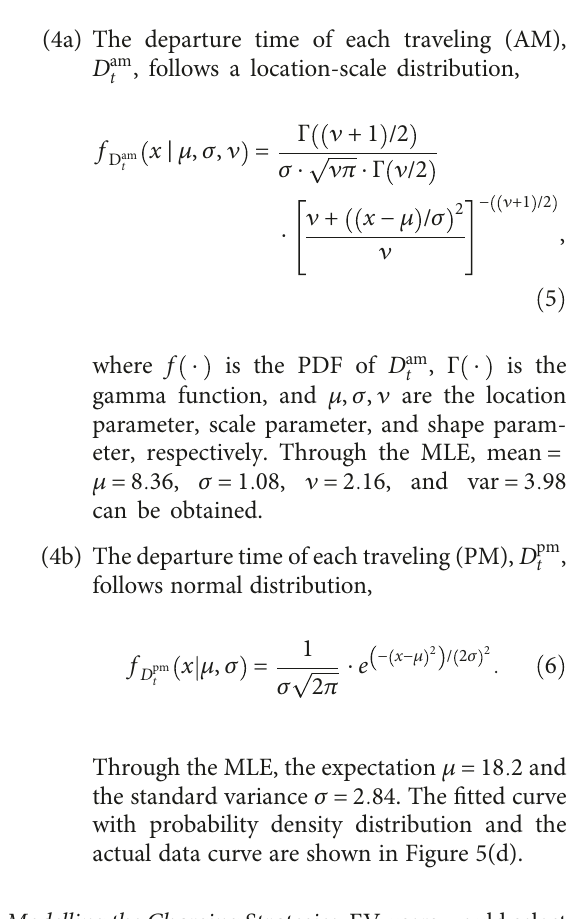
Figure 4: Diagram of the distribution function selection of the involved traveling